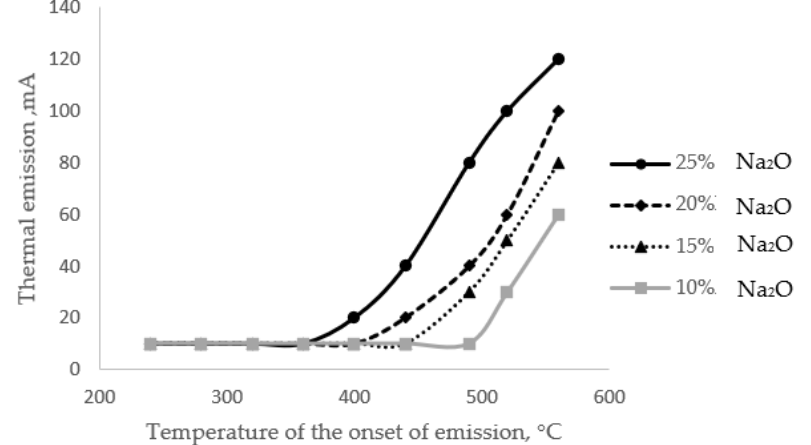
Figure 4. Activated thermal emission curves for glasses with different alkali contents.